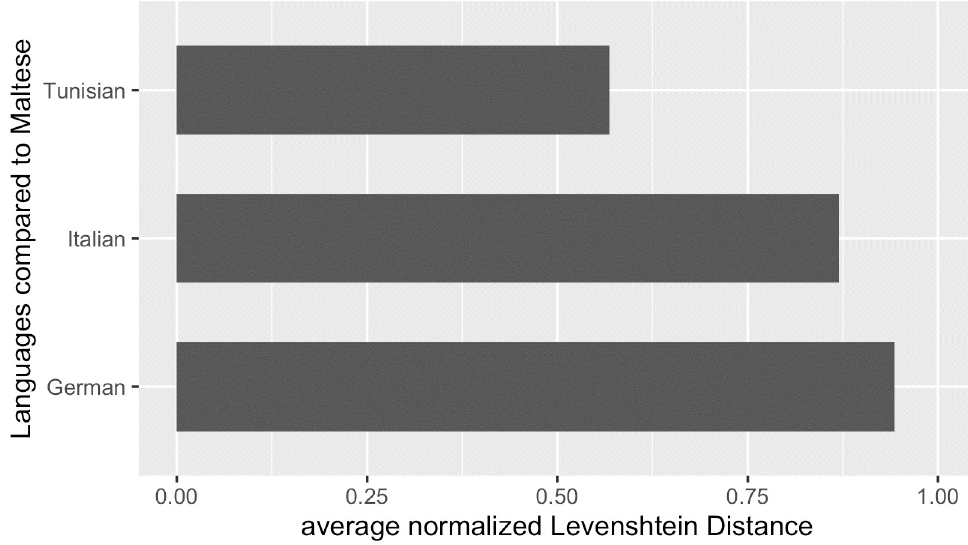
Fig 3. Language similarity operationalized as average normalized Levenshtein distance between Maltese-Tunisian, Maltese-Italian and Maltese-German (based on the ASJP database by [38]).